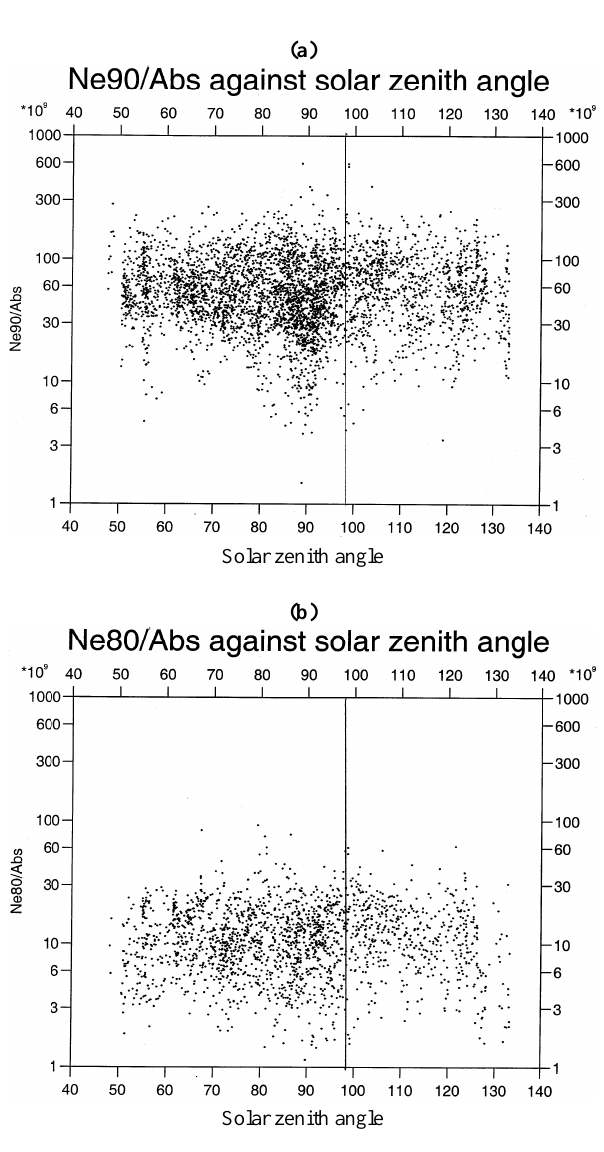
Fig. 6. N e /A against the solar zenith